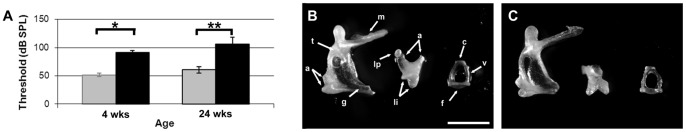
Hearing Profile (A) and middle ear bone dissections (B–C) of eeyore mice.ABR thresholds of hearing (grey bars) and deaf (black bars) eeyore littermates at 4 (*p = 4.8×10−10) and 24 (**p = 1.2×10−10) weeks of age. The ossicles appear largely normal in deaf mice (C), comparable to normal morphology of the malleus, incus and stapes in normal hearing mice (B). M; manubrium of malleus, A; articulation surfaces of malleus and incus joint, T; tubercle, G; gonial angle, LI; attachment points of suspensory ligaments of incus, LP; lenticular process, C; capitulum of stapes, V; arched ventral crus, F; footplate. Scale bar: 1 mm.